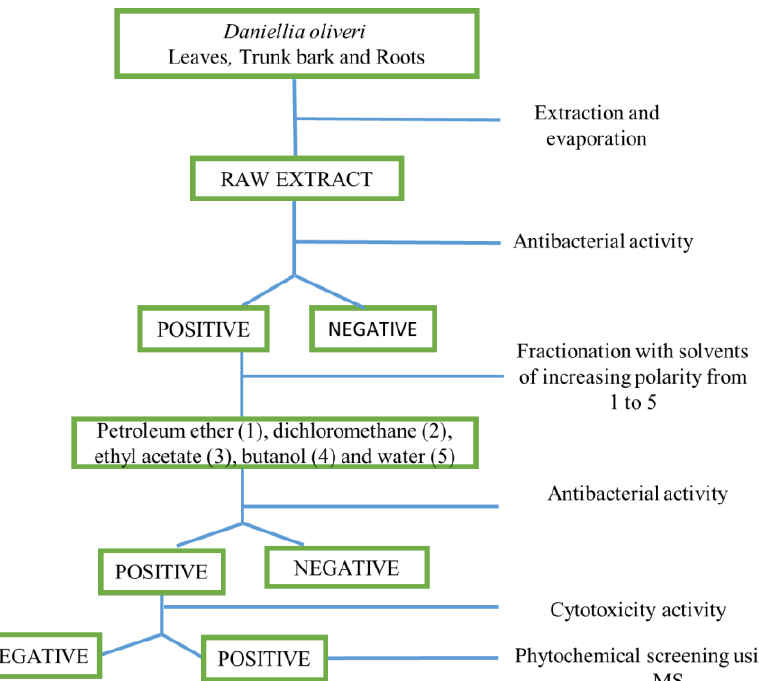
Figure 1. Flowchart of the bio-guided isolation assay performed on the different parts of D. oliveri. Raw extract: methanolic (MeOH) raw extract. Bioassays (i.e., antibacterial activity)—Positive: antibacterial activity against bacteria; Negative: no antibacterial activity. Cytotoxic activities—Positive: not toxic to normal human MRC-5 cells; Negative: toxic to MRC-5 cells.